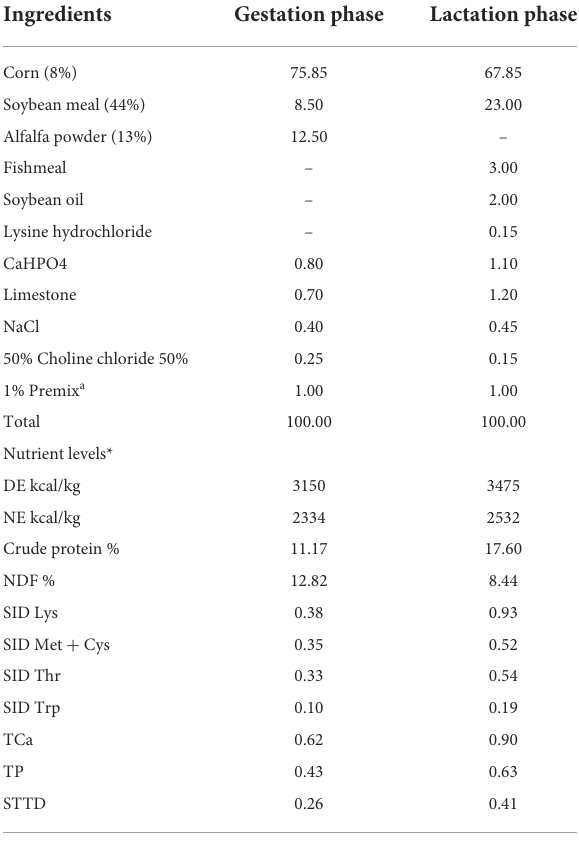
TABLE 1 Composition and nutrient levels of the basal diet on (air-dry basis).